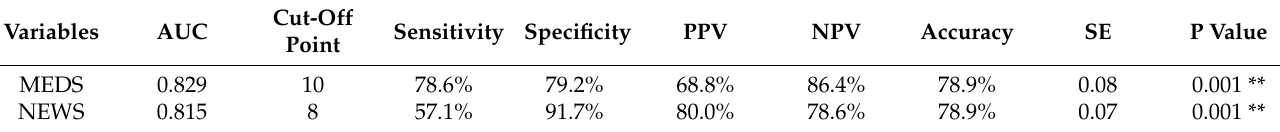
monocytogenes the mortality risk in bacteremic patients of Listeria monocytogenes .